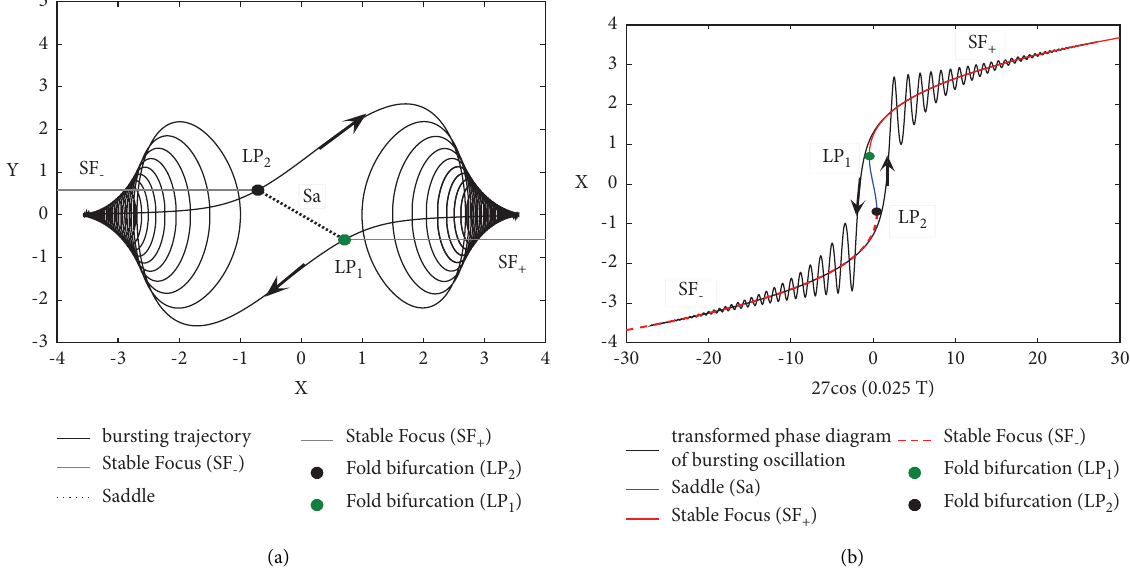
Figure 12: (a) Chaotic phase portrait in ( X − Y ) plane obtained with the parameters of Figure 8(a) together with the equilibrium points of the plant-wind system defned in Figure 11(a) and (b) transformed phase diagram of bursting trajectory for ξ � 0 .